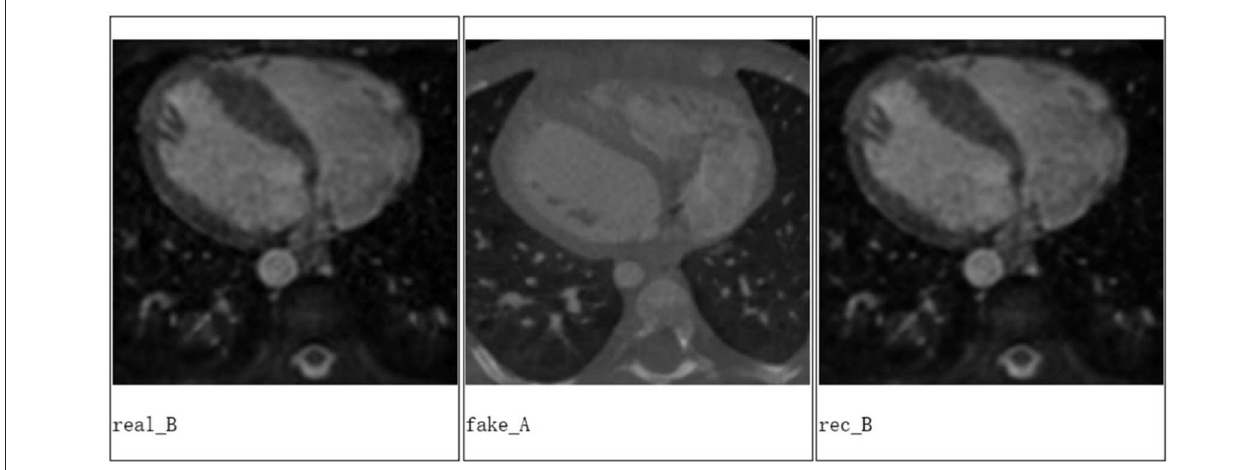
FIGURE 3 | The experiment results from Cycle-GAN, where real B is the real MRI image, fake A is the generated CT image based on the real MRI image, and rec B is the reconstructed MRI image based on the generated CT image of heart for a patient.